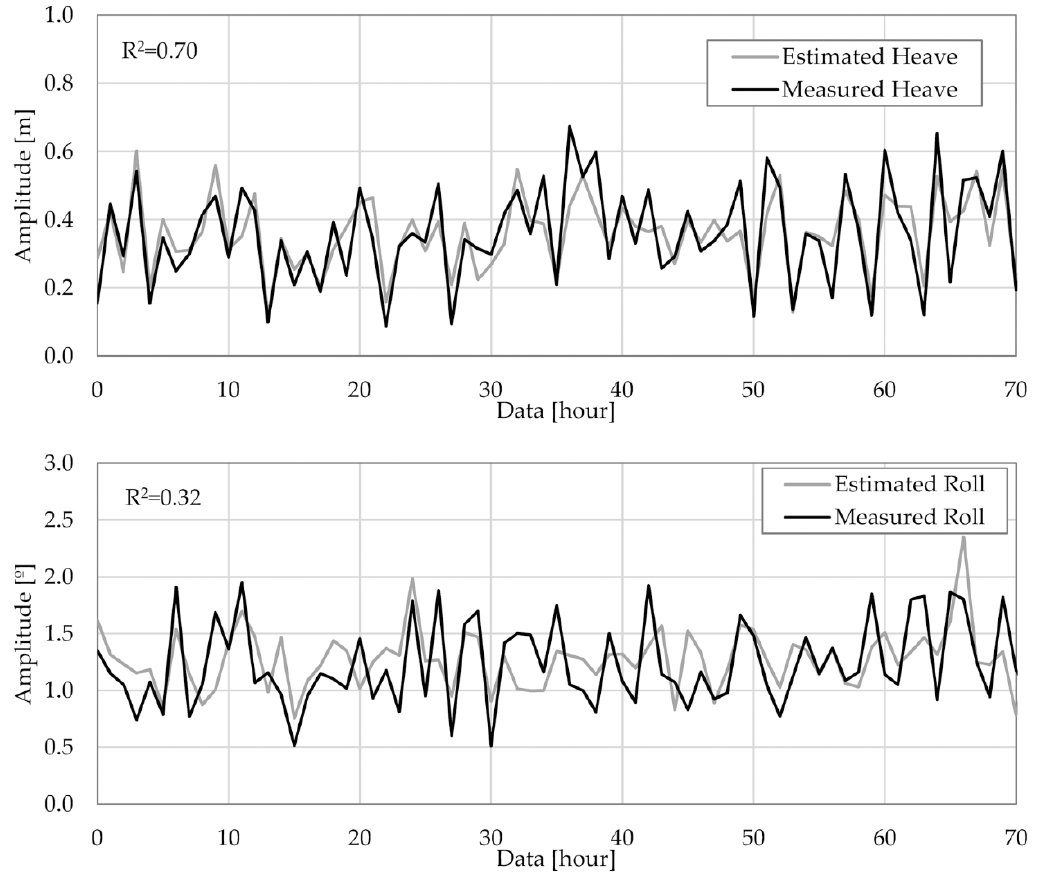
Figure 10. Comparison between measured and estimated values of heave and roll motions.